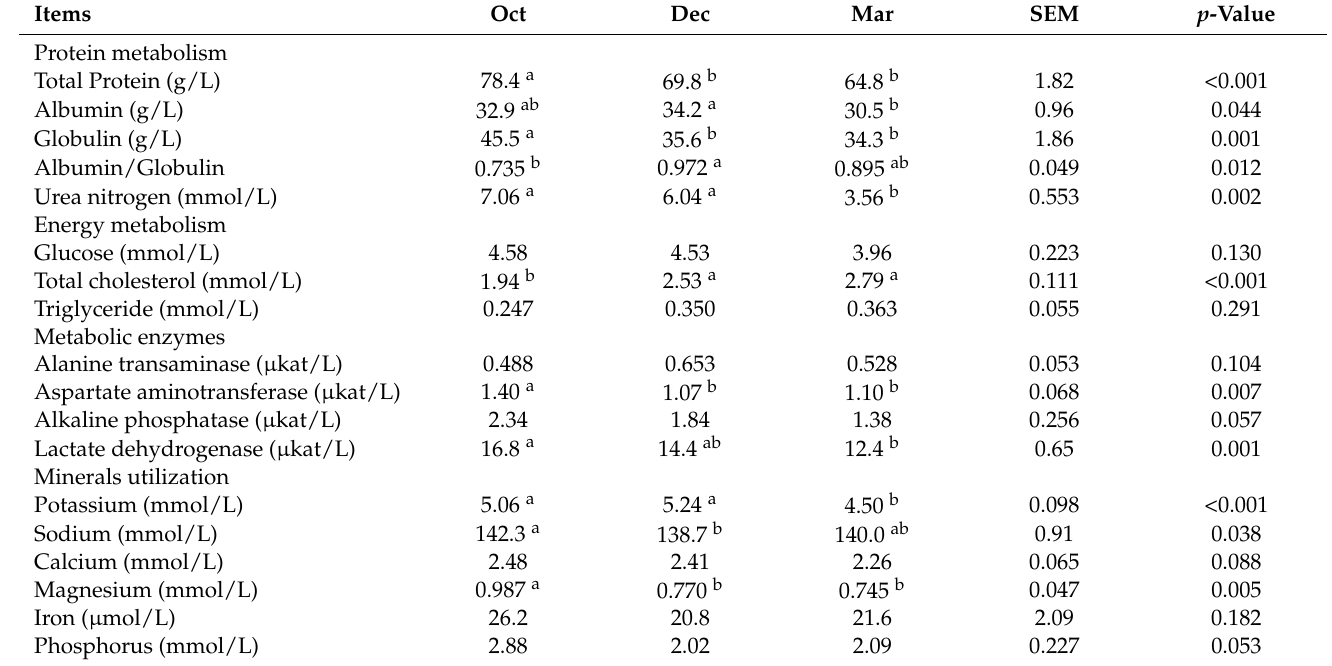
Values with different superscripts represent significant differences among groups ( p < 0.05).